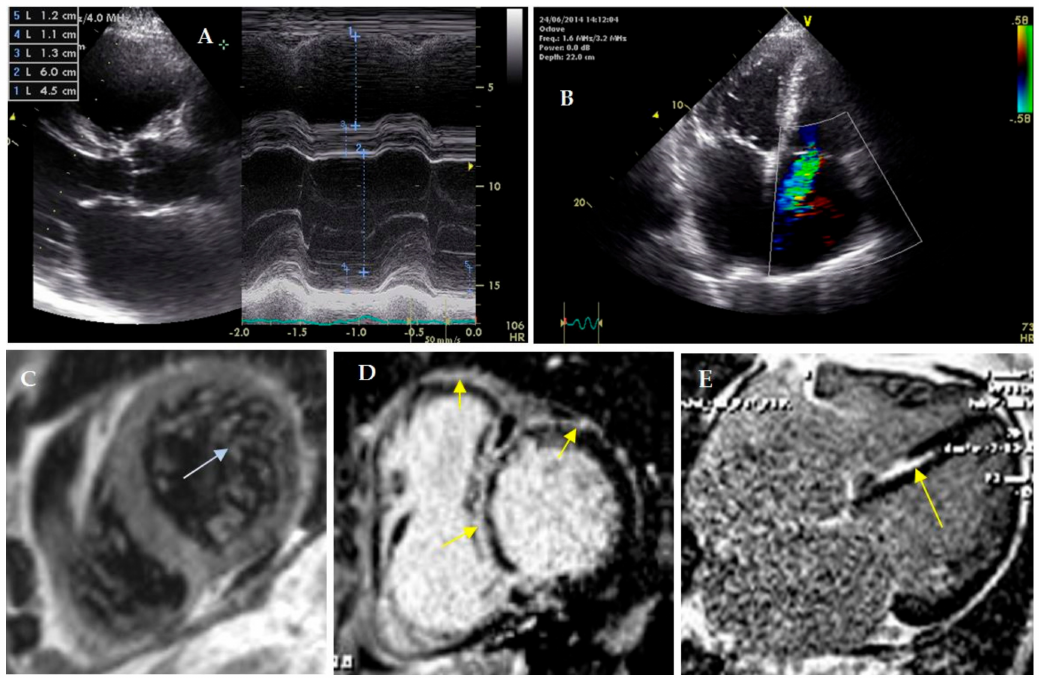
Figure 2. Cardiac visualization of proband. ( A – C )—ultrasound cardiography. ( C – E )—cardiac MRI with gadolinium. ( A )—enlarged right ventricle and normal size of left ventricle; ( B )—sever tricuspid regurgitation (Doppler). ( C )—left ventricular noncompaction, ratio of noncompact and compact layers 3.5: 1, ( D , E )—foci of late gadolinium enhancement in septum (subendocardial, intramyocardial), right ventricle and anterior wall of left ventricle